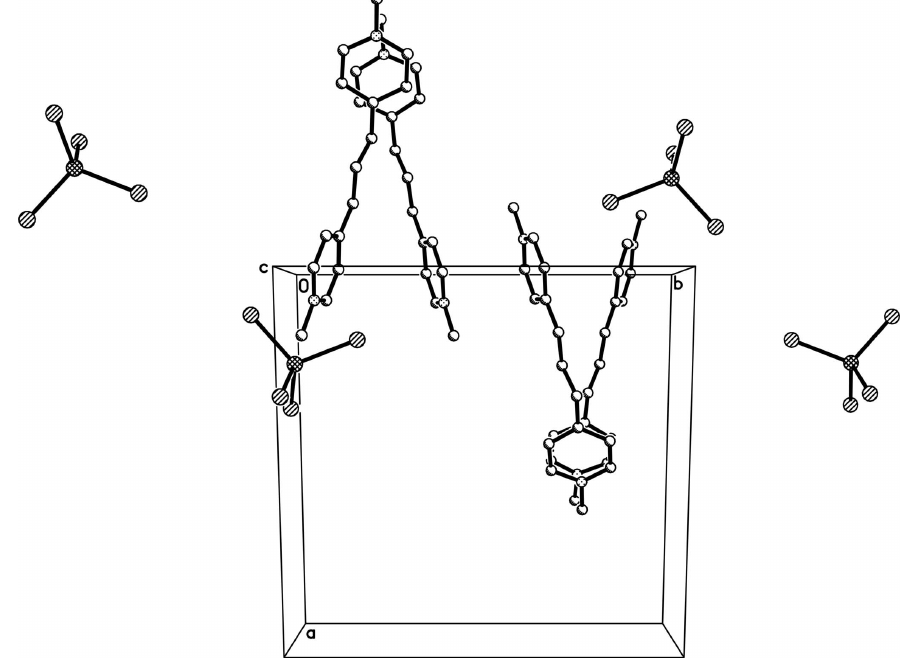
Figure 2 A partial packing view of (I) along the c axis. For the sake of clarity, H atoms have been omitted. 1,1 ′ -Dimethyl-4,4 ′ -(propane-1,3-diyl)dipyridinium tetrabromidocadmate(II) Crystal data (C H N )[CdBr ] 15 20 2 4 M r = 660.37